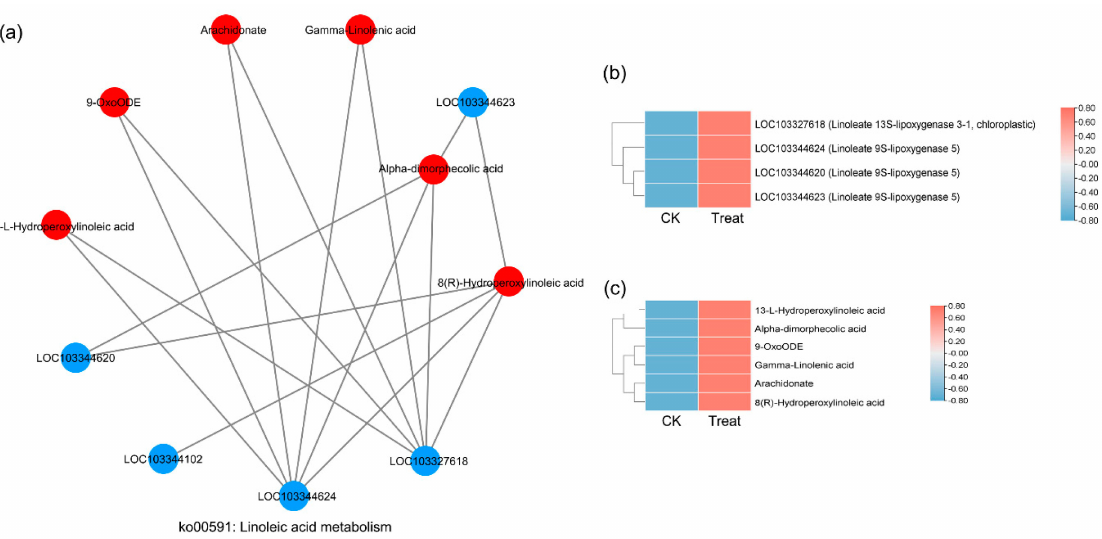
Figure 8. Correlation network diagram of the ko00591 pathway (linoleic acid metabolism). ( a ) The correlation network diagram. ( b ) The heatmap shows the expression level of correlated genes. ( c ) The heatmap shows the accumulation level of correlated